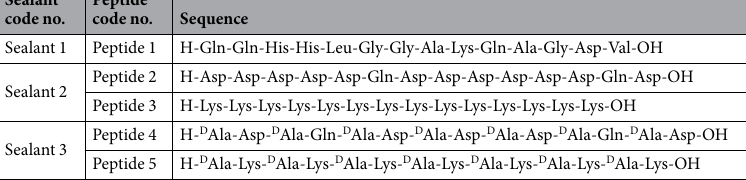
Sealant code no.